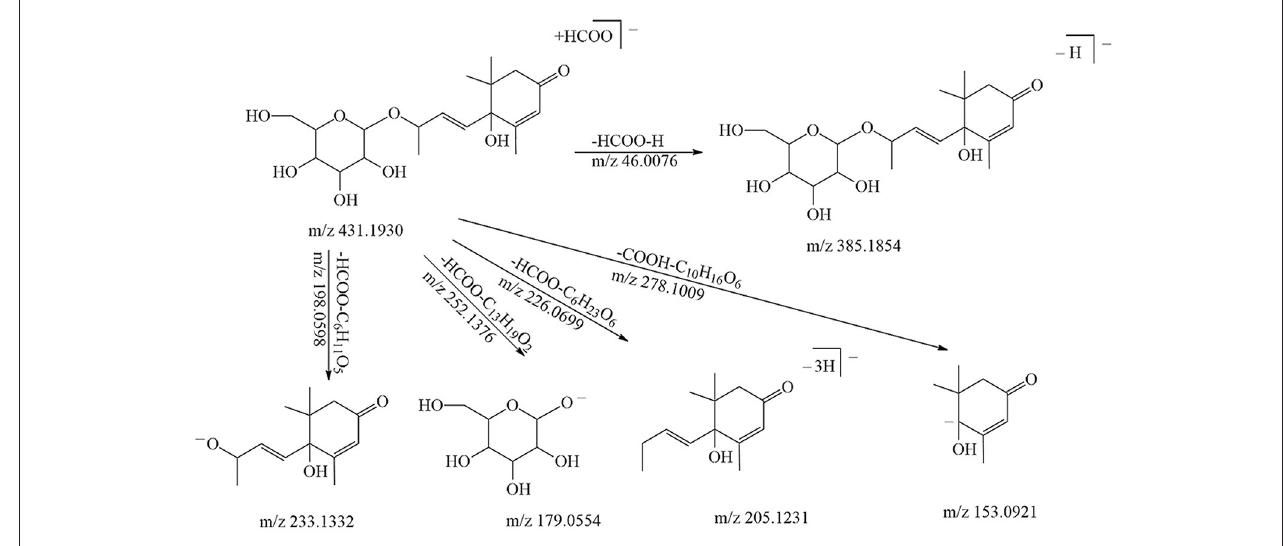
FIGURE 2 | Fragmentation pattern of a vomifoliol hexoside.